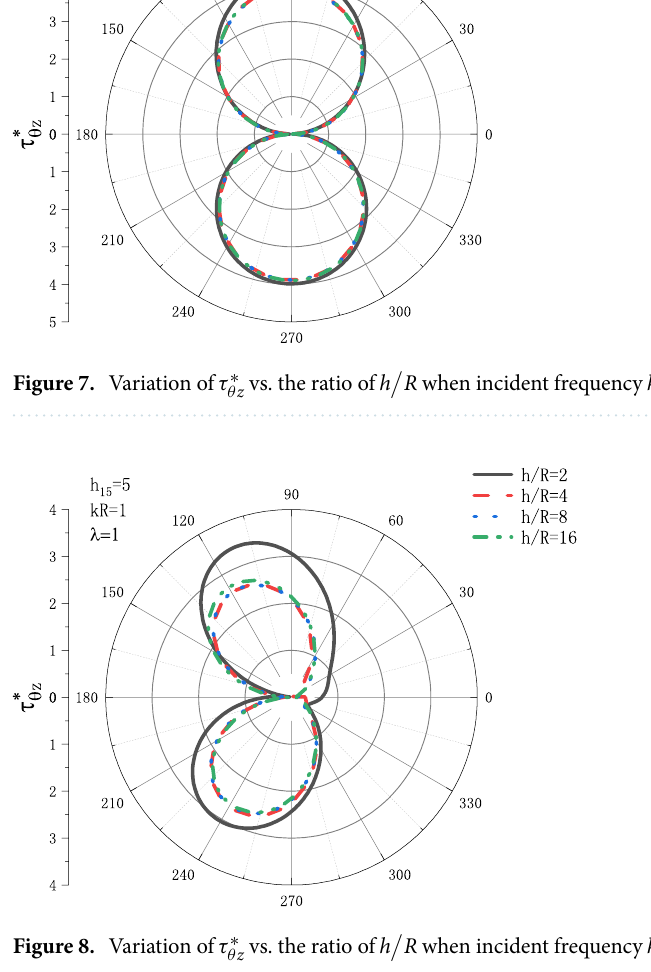
Figure 8. Variation of τ ∗ θ z vs. the ratio of h